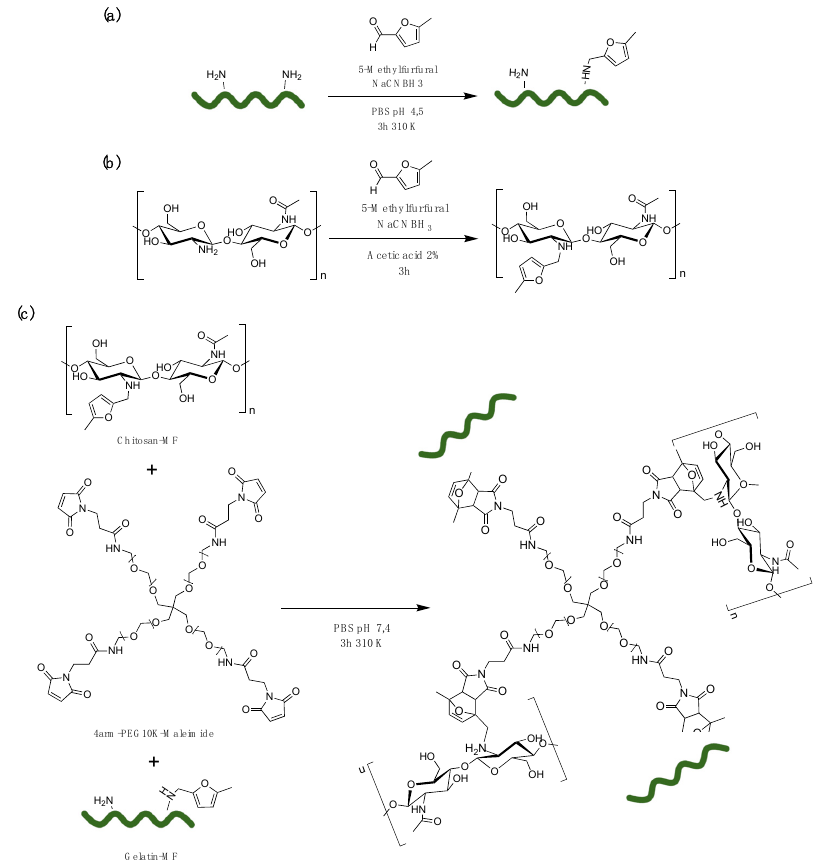
Scheme 1. Synthetic scheme of chitosan ( a ) and gelatin ( b ) functionalization with 5-methylfuran and GelChiDA hybrid biopolymer cross-linking reaction ( c ).